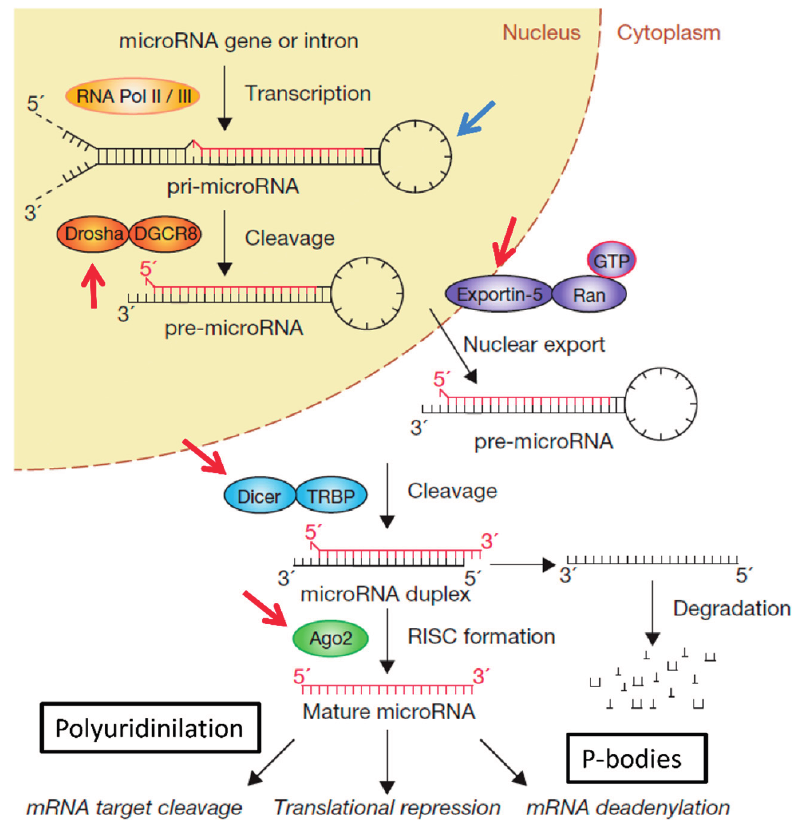
Figure 1. miRNA biogenesis and examples of post-transcriptional controls. MiRNAs are transcribed as pri-miRNAs by RNA polymerase II and processed by the endonuclease Drosha/DGCR8 to a shorter pre-miRNA hairpin structure. The pre-miRNA is exported to the cytoplasm by the Exportin-5–Ran-GTP and cleaved by DICER/TRBP complex to generate the mature length of the miRNA structure. One strand of the miRNA duplex, the guide strand, is then loaded with Argonaute (Ago2) proteins into the RNA-induced silencing complex (RISC), where it guides RISC to silence target mRNAs through mRNA cleavage or translational repression. Beyond this well described linear miRNA processing pathway, miRNA biogenesis is also subject to complex post-transcriptional controls. Some are indicated by the arrows in the figure. These include RNA editing of the pri-miRNA structure (blue arrow), regulation of miRNA biogenesis partners (red arrows), trafficking to P-bodies and polyuridylation for miRNA stability, cytosolic abundance and Dicer processing. Reprinted and adapted with permission from